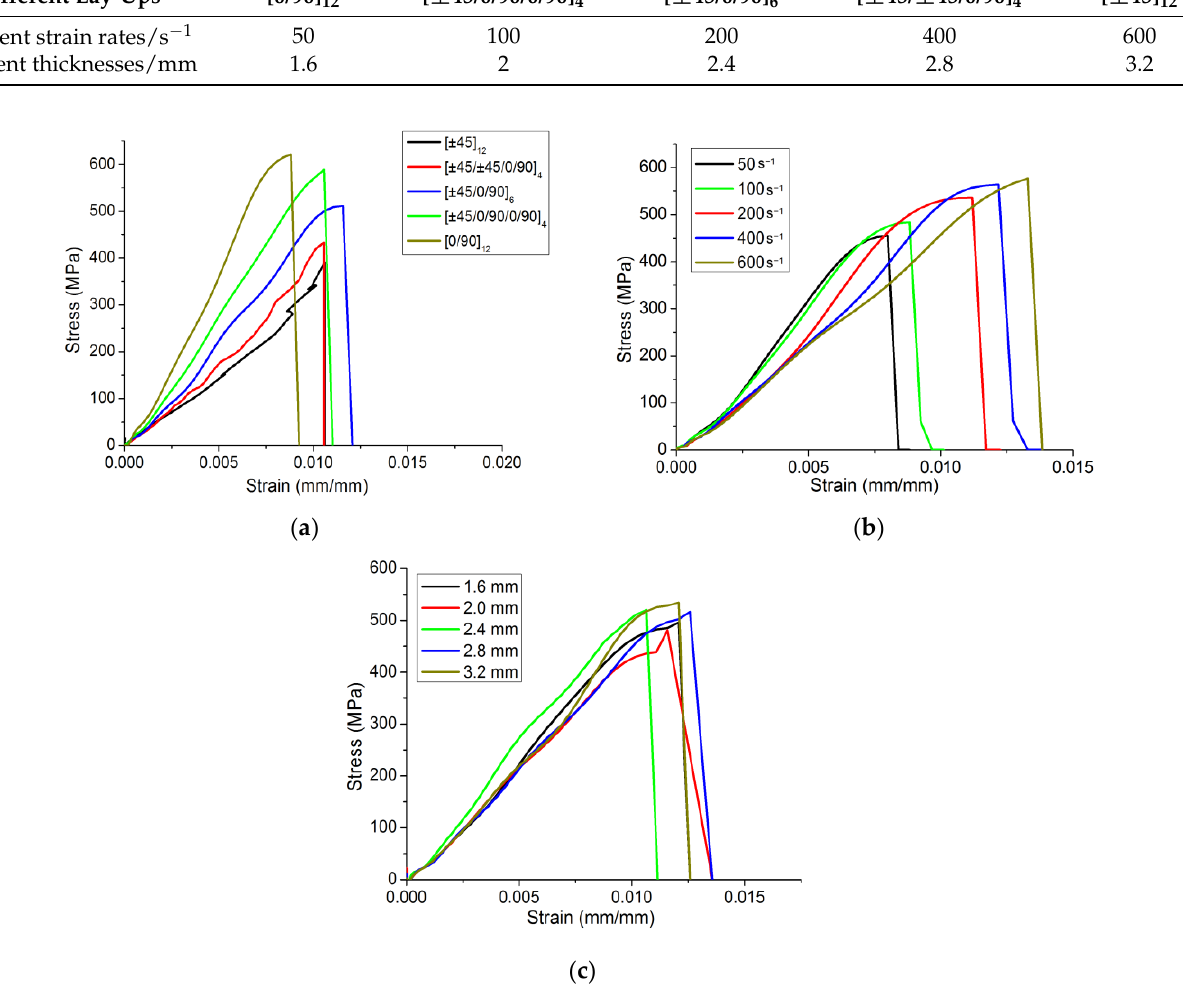
Figure 10. Stress – strain curves obtained with the finite element model for different ( a ) lay-ups, ( b ) strain rates, and ( c )